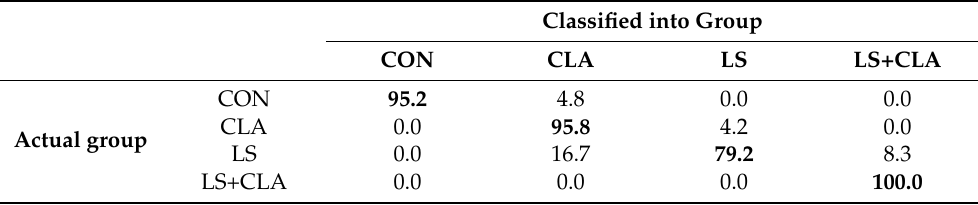
Table 3. Classification matrix in percentage using the spectral information of the fat samples scanned from 3000 to 1000 cm − 1 . Correctly classified cases are in diagonal marked in